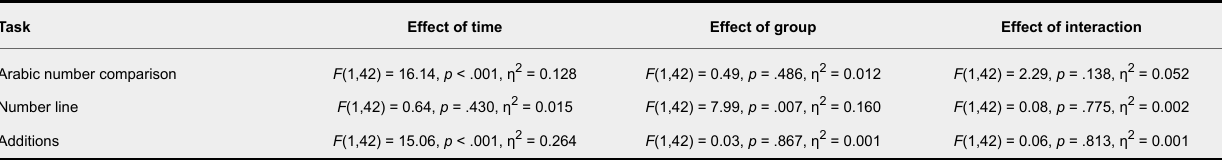
Results of the ANOVAs of the Long-Term Effects on Numerical Baseline Tasks